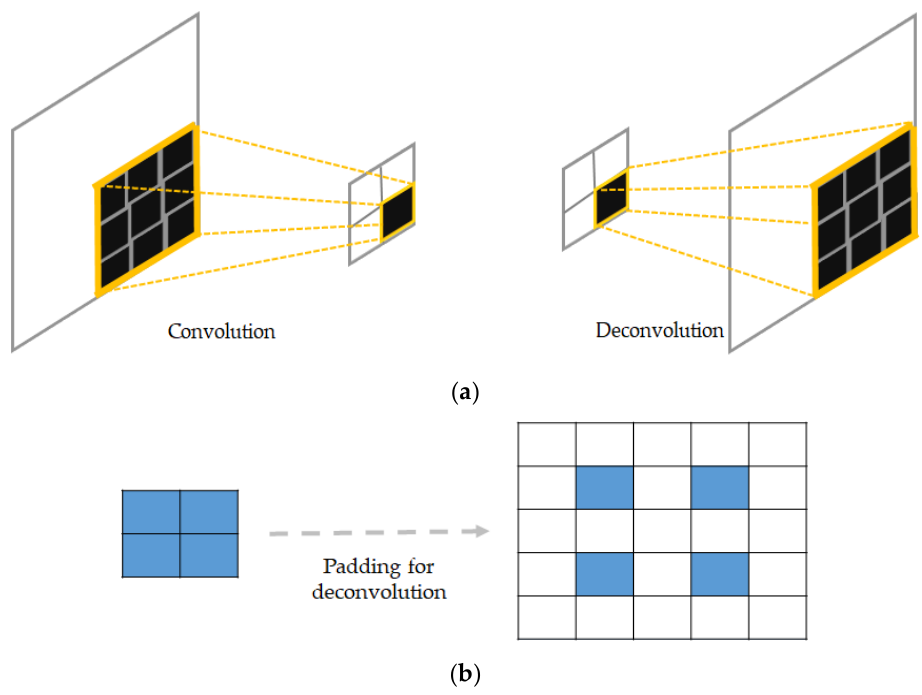
Figure 11. ( a ) Illustration of convolution and deconvolution; and, ( b ) illustration of padding for backwards convolution (deconvolution).